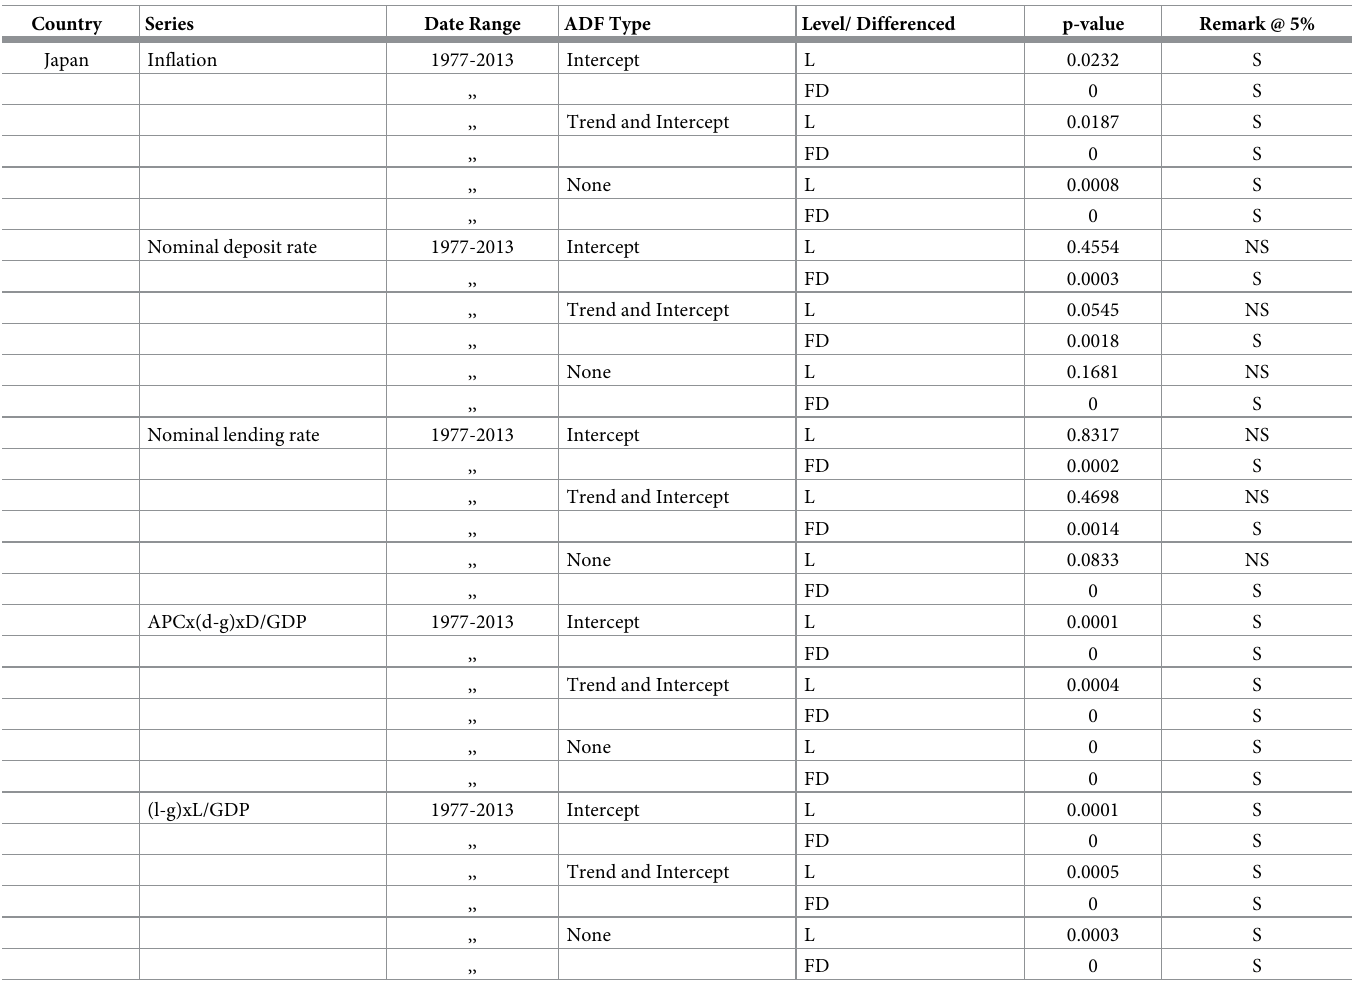
Table 2. ADF Unit Root